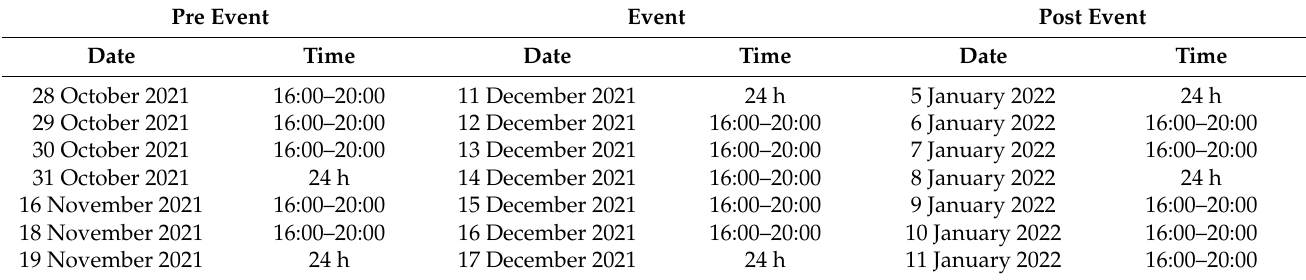
Table 1. The dates and time of behavioural observations throughout the study period.